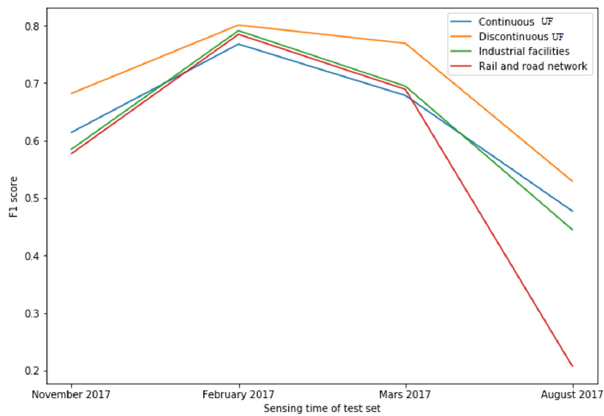
Figure 14. The computed F1 score for each sensing time per class.